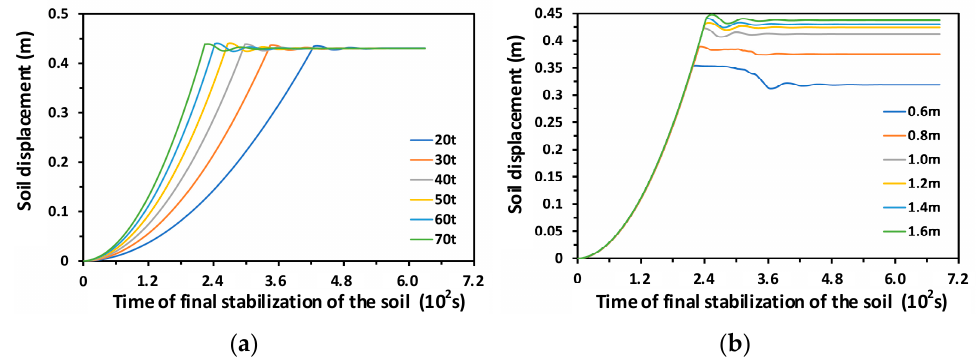
Figure 19. Displacement of the soil at the bottom with different lifting forces and burial depths: ( a ) burial depth, 1.6 m; ( b ) lifting force, 50 t.